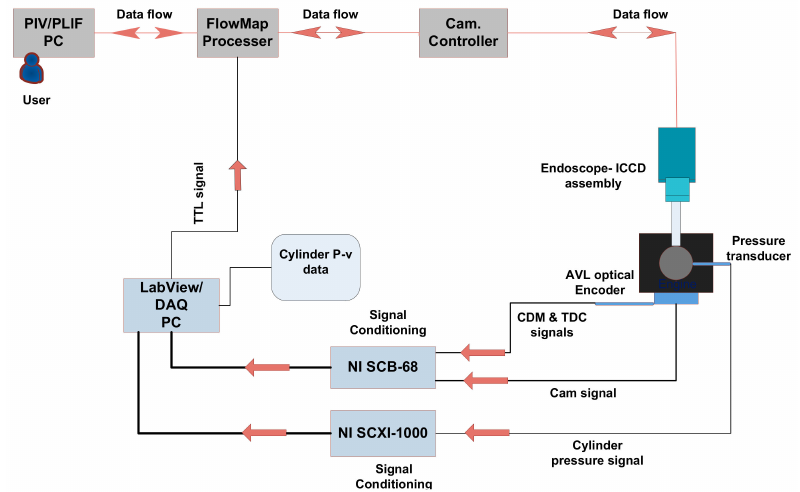
Figure 3. The experimental setup for flame imaging.